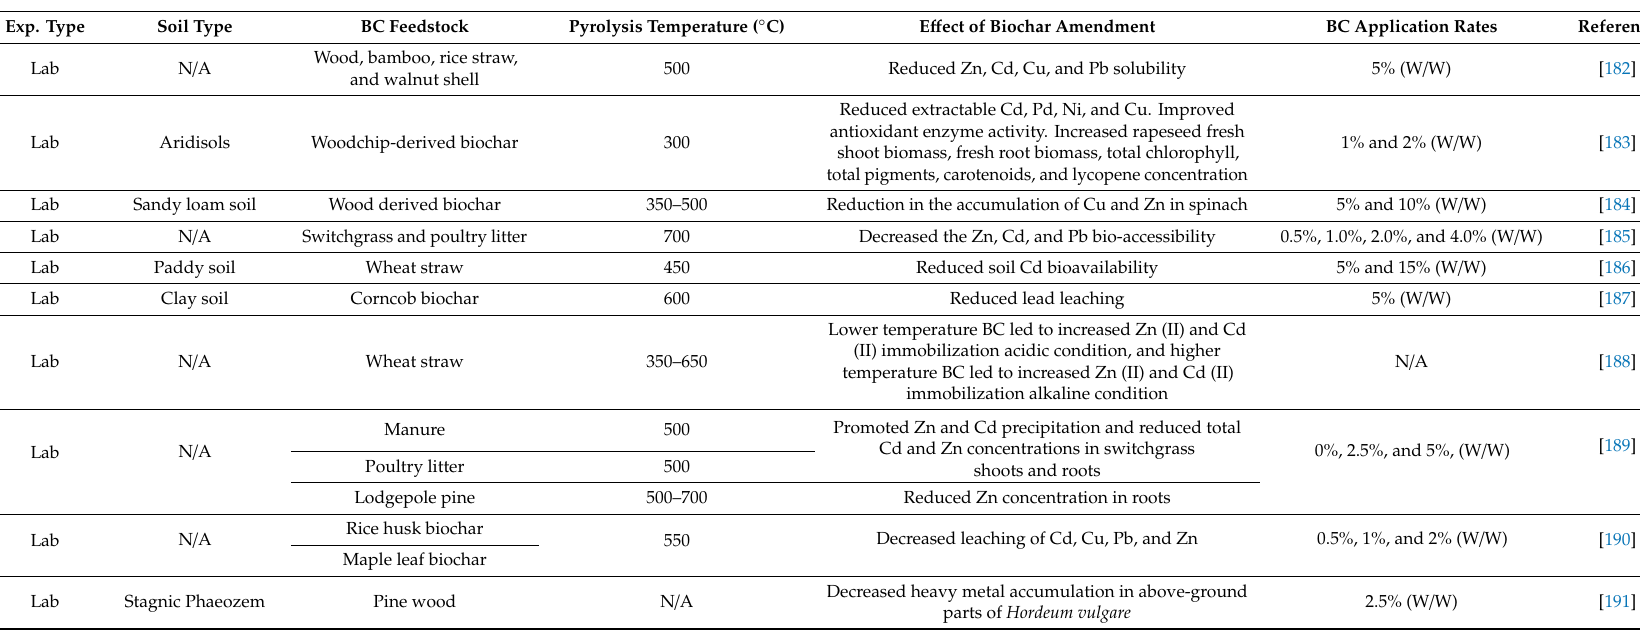
Table 4. Selected recent studies reporting the e ff ect of biochars (BCs) derived from various feedstocks on heavy metal remediation in di ff erent types of soils. Exp.